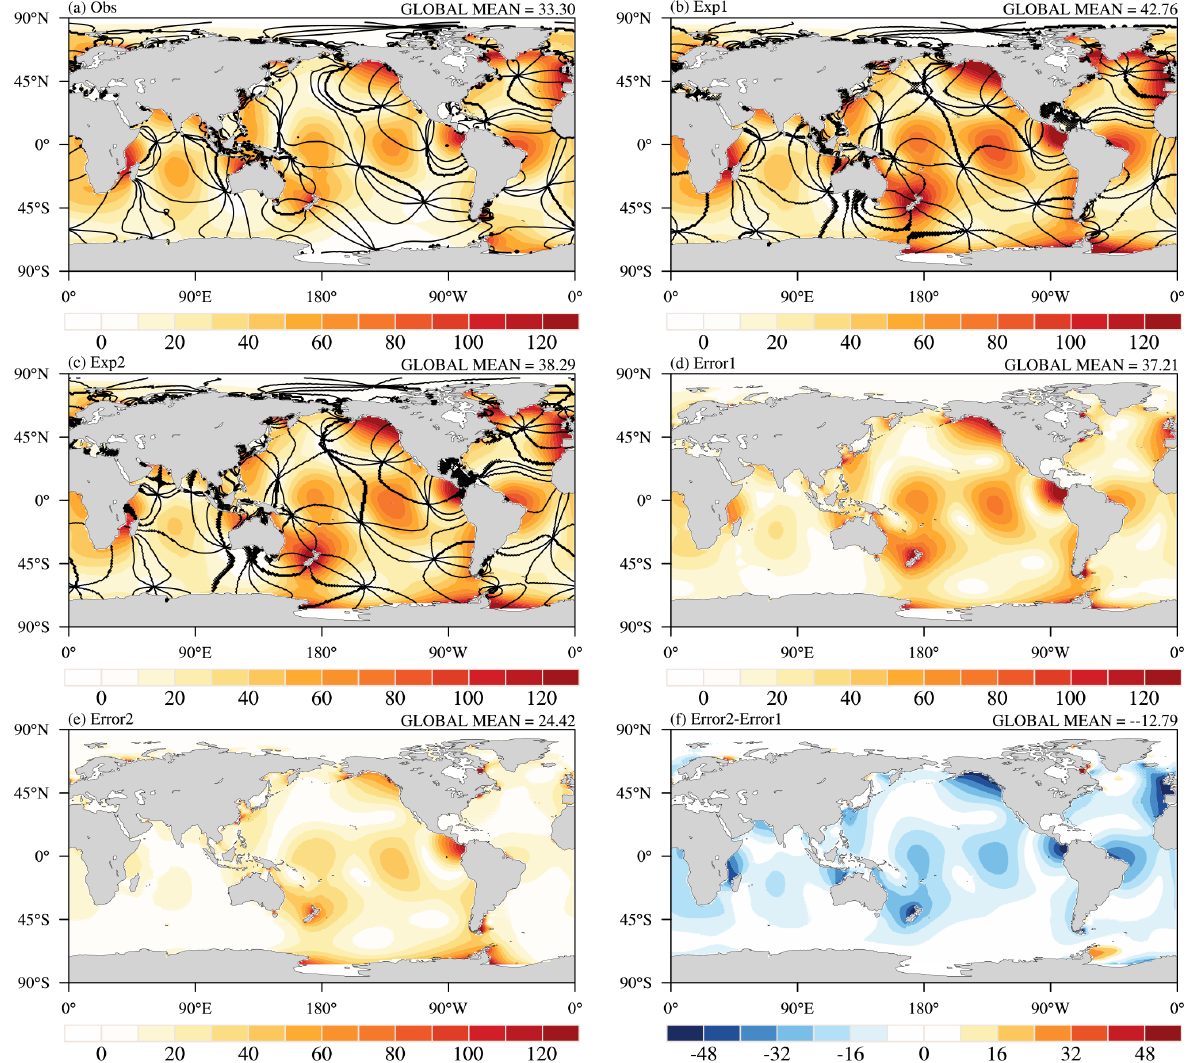
Figure 6. Spatial patterns of the amplitude and phase of M2 for (a) the observation (Obs), (b) Exp1, (c) Exp2, (d) the total error for Exp1, (e) the total error for Exp2, and (f) the difference in error between Exp2 and Exp1. The observation is from TPXO9v2 (Egbert and Erofeeva, 2002). The units are centimeters, and the lines of the constant phase are plotted every 45 ◦ in